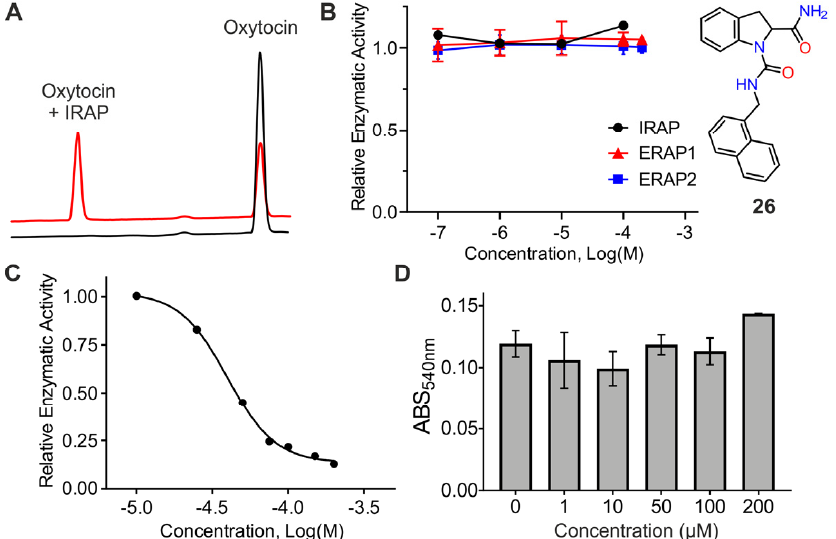
- a Limited inhibition observed only at the highest concentration tested; NI : no inhibition; (-) not tested. 2.6. Inhibition of Oxytocin Trimming Although small substrates are a useful tool for characterization of inhibitors of ami- nopeptidases, the allosteric nature of the targeted site and the complex mechanism em- ployed by IRAP [30] prompted us to also characterize the activity of the compounds in inhibiting the hydrolysis of a physiological substrate of IRAP, oxytocin [31]. The cleavage of the N-terminal residue of the cyclic nonapeptide oxytocin can be followed by high-perfor- mance liquid chromatography on a C18 reversed phase column (Figure 5A). This assay was validated using DG013A and KE552 as described above for the Leu-AMC substrate. DG013A was able to completely inhibit oxytocin trimming by IRAP when used at a con- centration of 1 μ M as expected by its calculated IC 50 for Leu-AMC. Remarkably, KE552 was less effective against oxytocin and inhibited only 10% of trimming at 10 μΜ and up